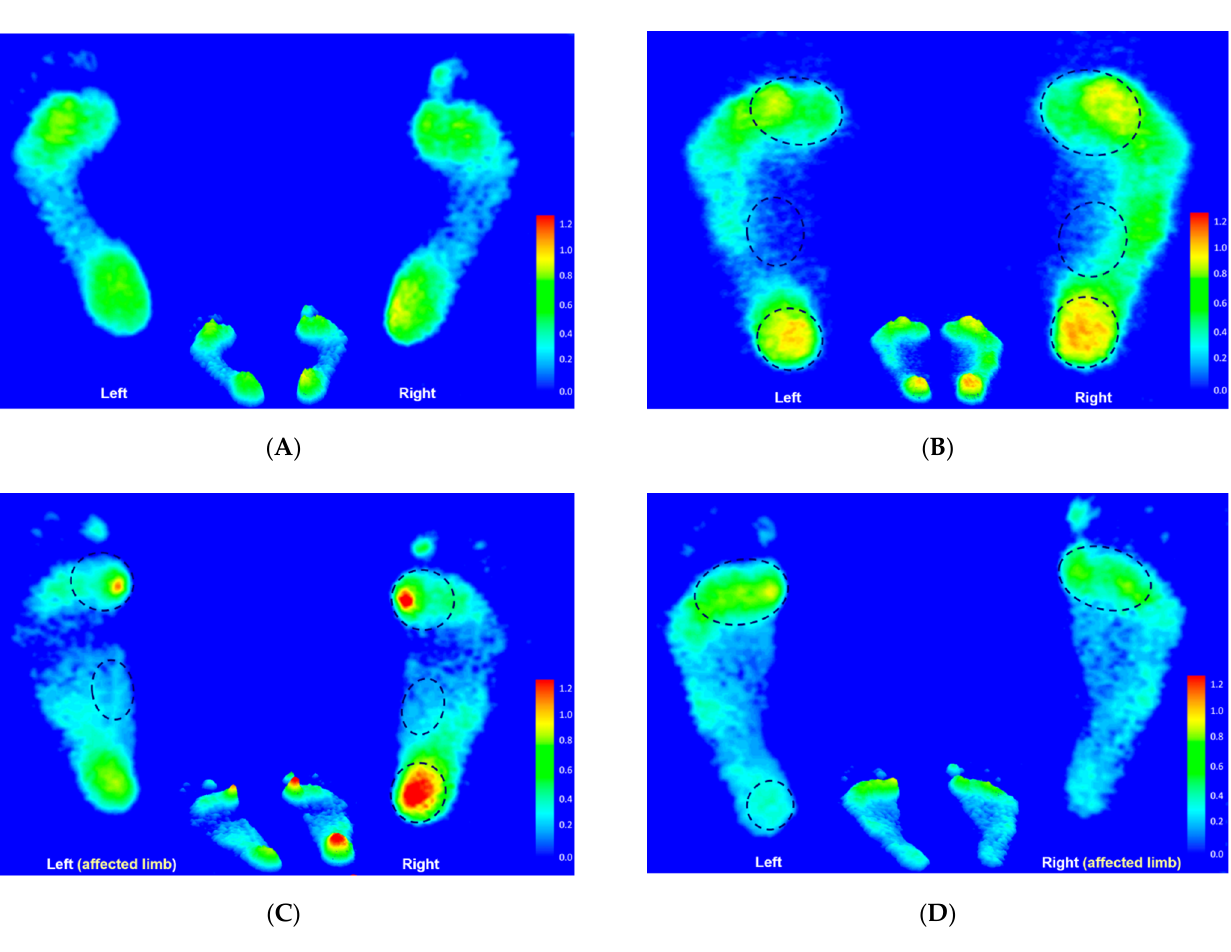
Figure 11. The static footprint characteristics of the representative participant in the control group ( A ), the CP group ( B ), the left hemiplegic CP group ( C ), and the right hemiplegic CP group ( D ). Black circles indicate the areas of higher relative loading.